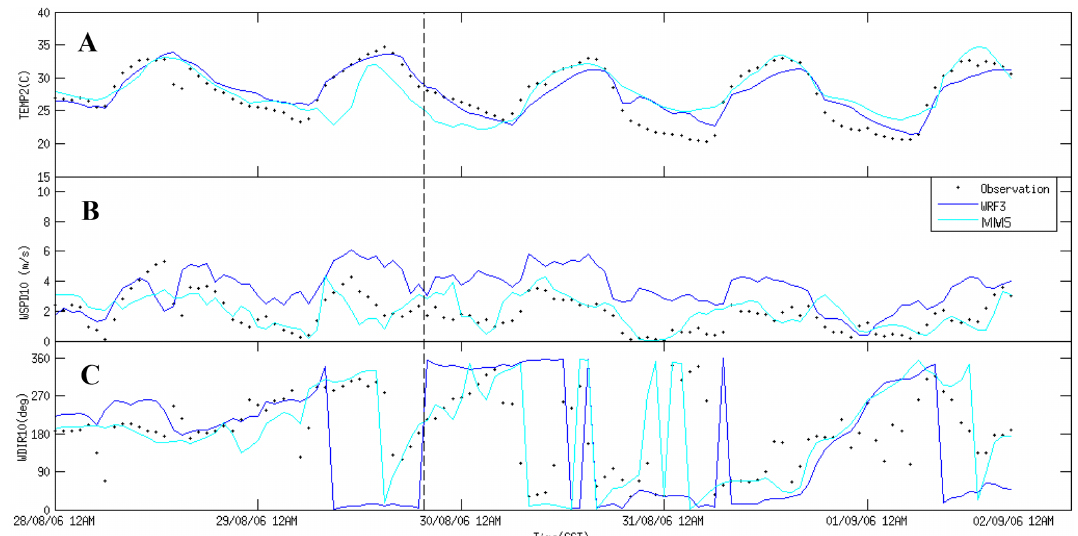
Figure 3. Time series of temperature (a) , wind speed ( (b) , and wind direction (c) for observations (dots) and for the WRF (blue) and MM5 with EDAS (green) models. The dotted line marks the beginning of postfrontal